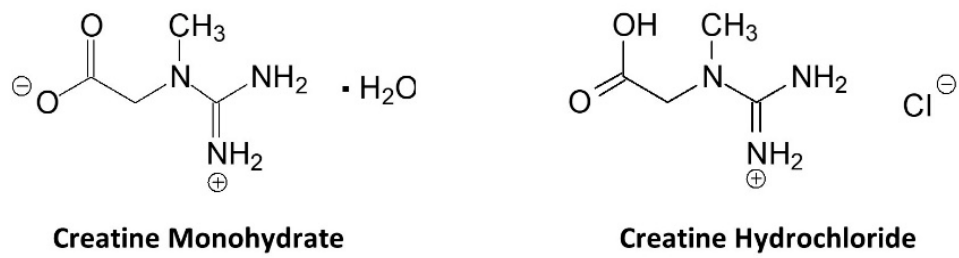
Figure 11. Comparison of creatine monohydrate and creatine HCl structures.